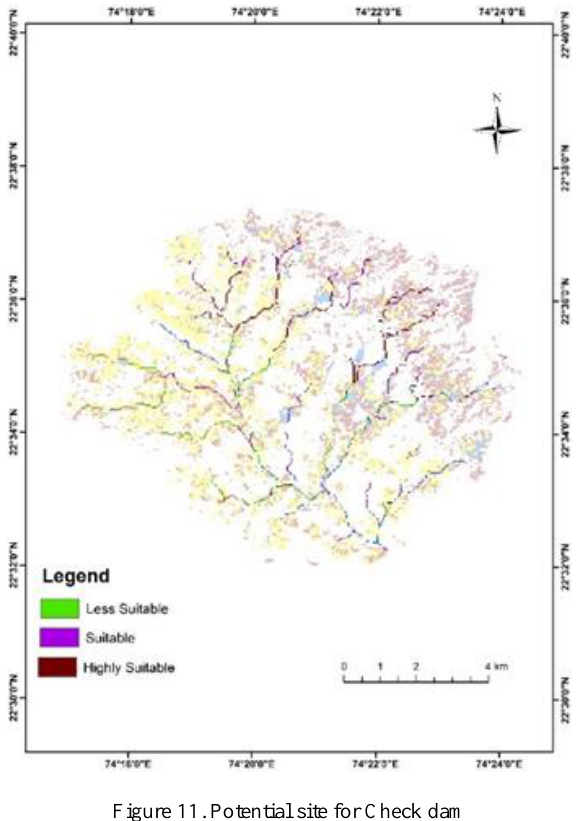
Figure 11. Potential site for Check dam